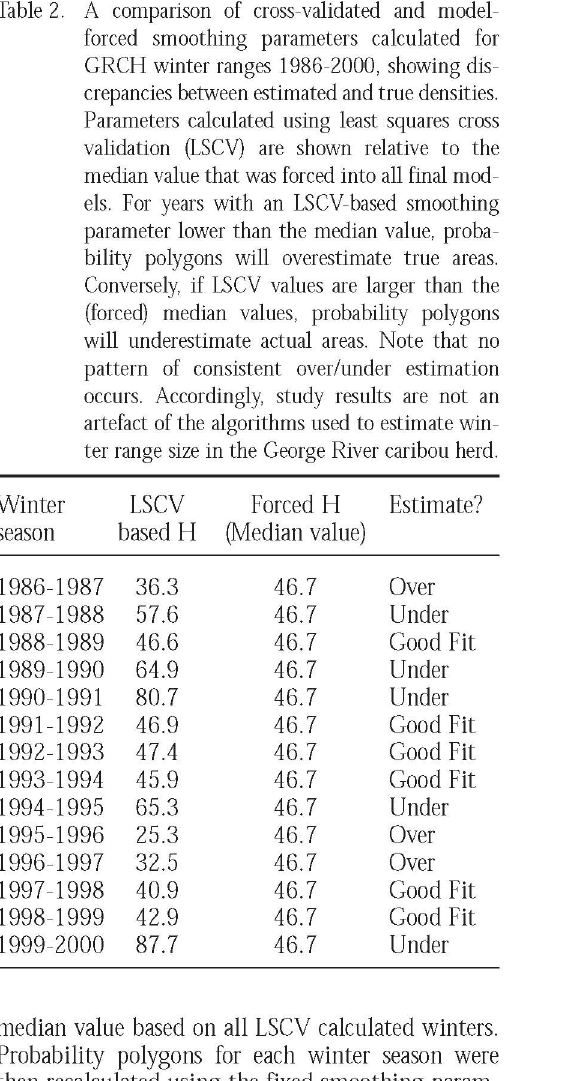
Table 2. A comparison of cross-validated and model- forced smoothing parameters calculated for GRCH winter ranges 1986-2000, showing dis¬ crepancies between estimated and true